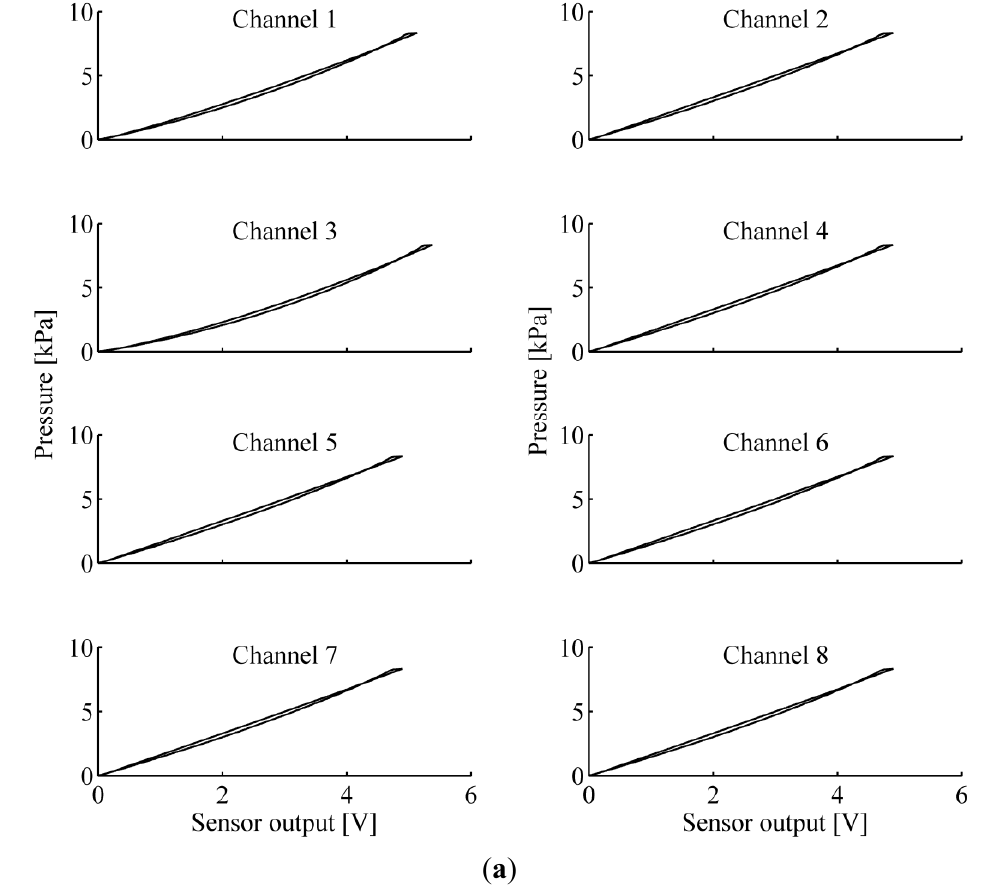
Figure 4. Force (or pressure) vs. output voltage of the PSP1 1 × 8 array of